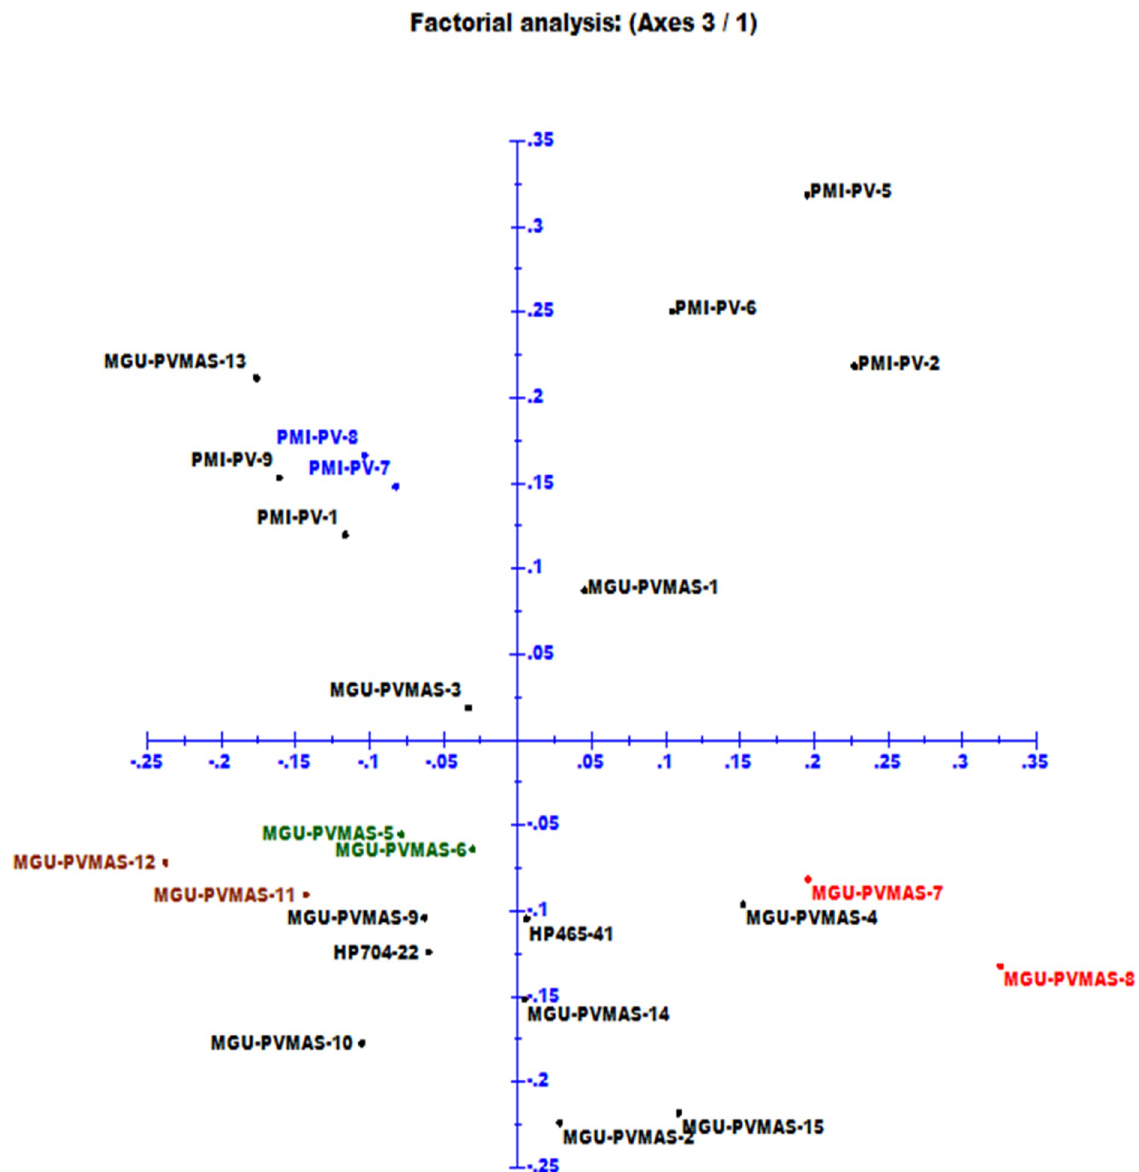
Fig 3. Principle coordinate analysis (PCoA) among 24 proA inbreds using SSRs. https://doi.org/10.1371/journal.pone.0245497.g003 Table 3. ANOVA of mean sum of squares for carotenoid components among 26 inbred lines. Source of Variations df BC BCX ProA LUT ZEA Non-ProA TC Replicates